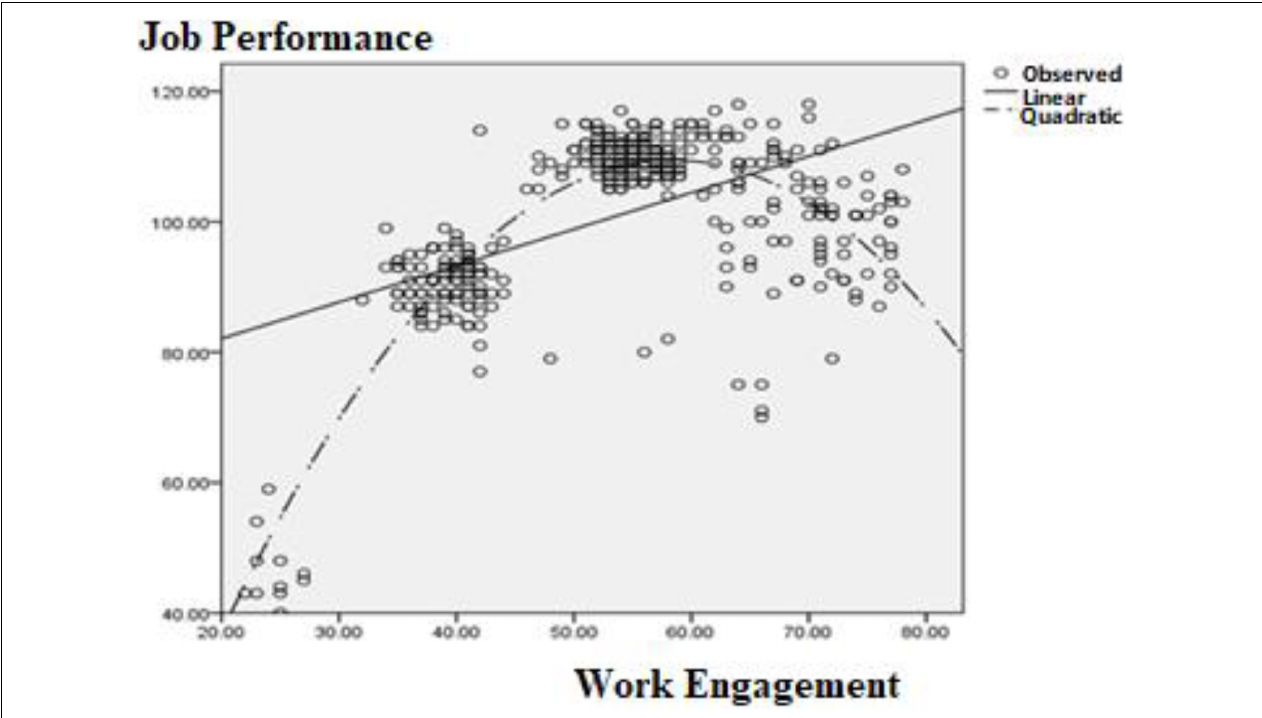
FIGURE 1 | Plot models and the relationship between work engagement and job performance.